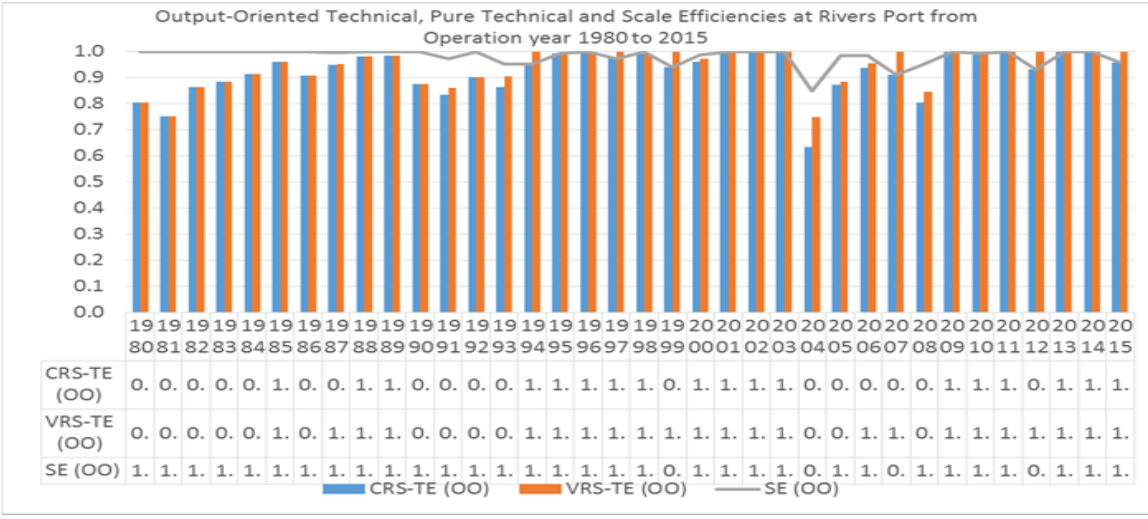
Figure 6: CRS – Technical Efficiency (Output-oriented) and CRS – Scale Efficiency (Output- oriented) at Rivers Port Complex from 1980 –